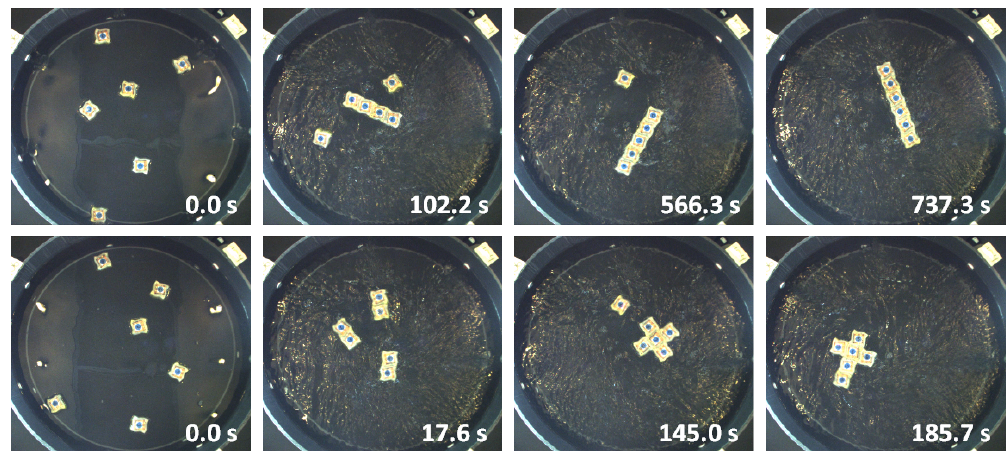
Figure 17. The progress of the SA process for the chain and cross shape target